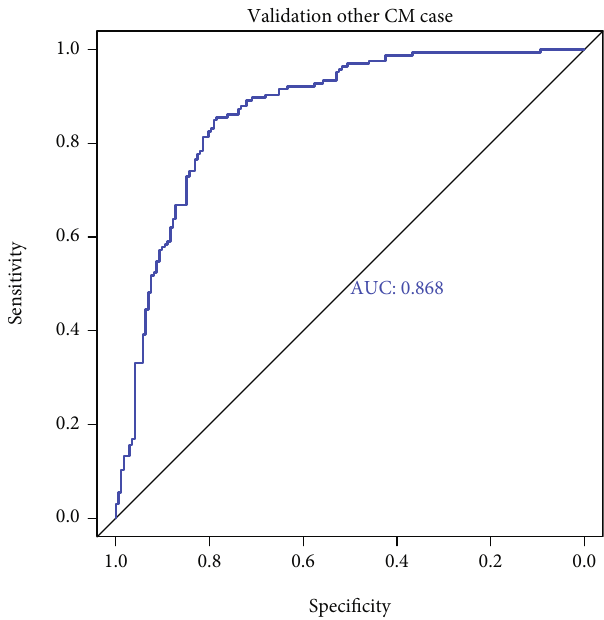
Figure 7: Receiver-operating characteristic (ROC) curve of peripartum cardiomyopathy